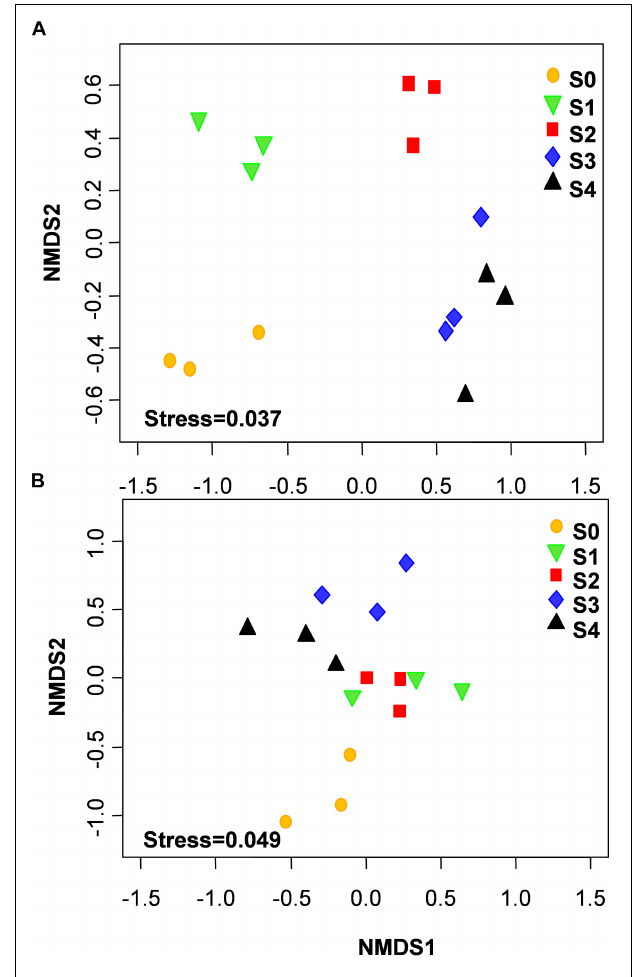
FIGURE 2 | Non-metric multidimensional scaling (NMDS) of bacterial (A) and fungal (B) community structures was calculated with Bray–Curtis distances during the composting